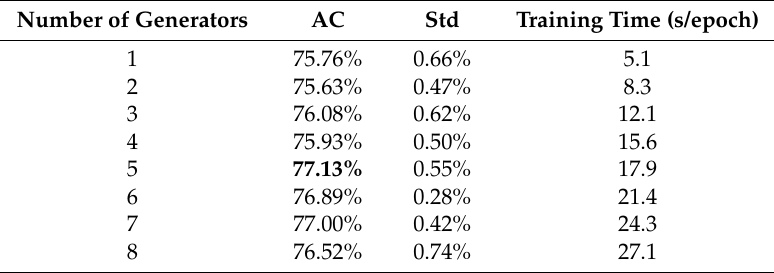
Table 5. The mean accuracy, STD, and training time of MCGAN with a different number of generators when trained by 400 labeled